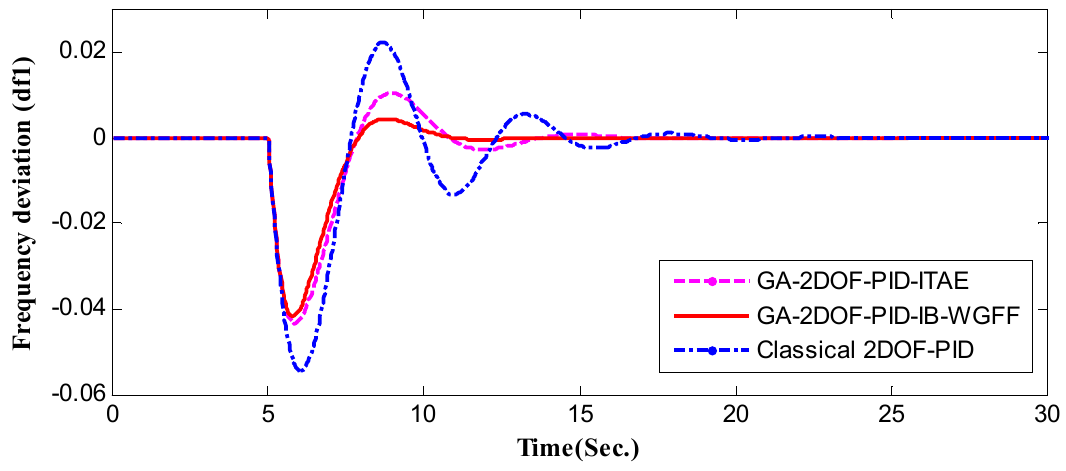
Figure 18. Δf (cid:2869) , using GA implementing ITAE, IB-WGFF and classical 2DOF-PID.